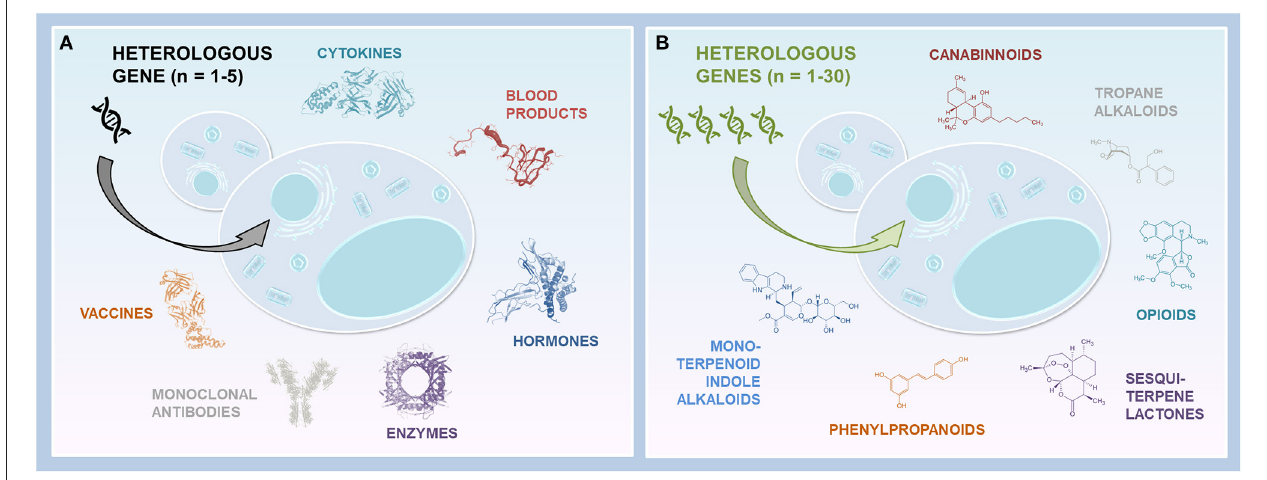
FIGURE 1 | Yeast platforms expressing heterologous genes. (A) Yeast cells producing biopharmaceuticals. Few heterologous genes are required to produce recombinant proteins of interest. In some cases, several genes are necessary (e.g., multiple gene copies, fusion proteins, Hb, glycosylation humanization). (B) Yeast cells producing NPs. Multiple heterologous genes are introduced into yeast to reconstitute the entire metabolic pathways and produce the compounds of interest, or their